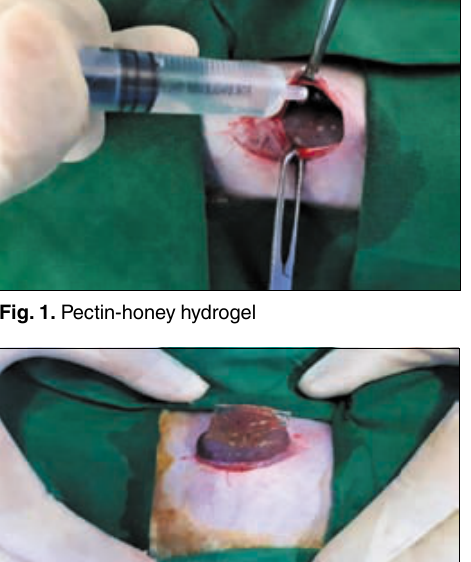
Konwar et al. (2019) in rabbits.